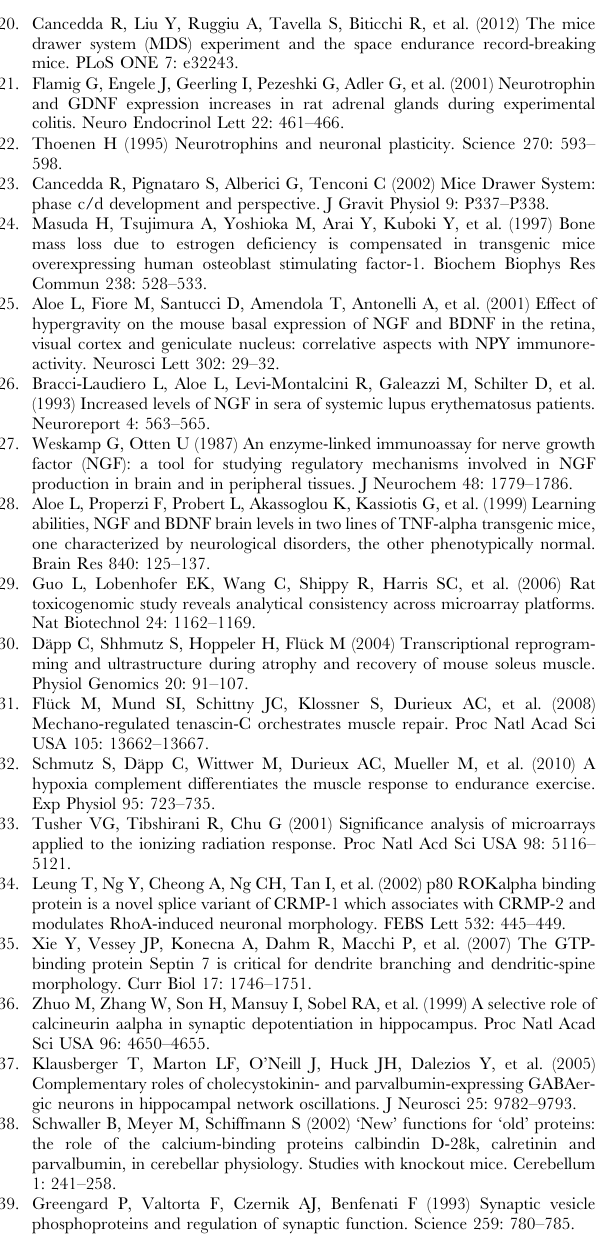
Table S1 Genes up-regulated by spaceflight (vs. ground control). Table S2 Genes down-regulated by spaceflight (vs. ground